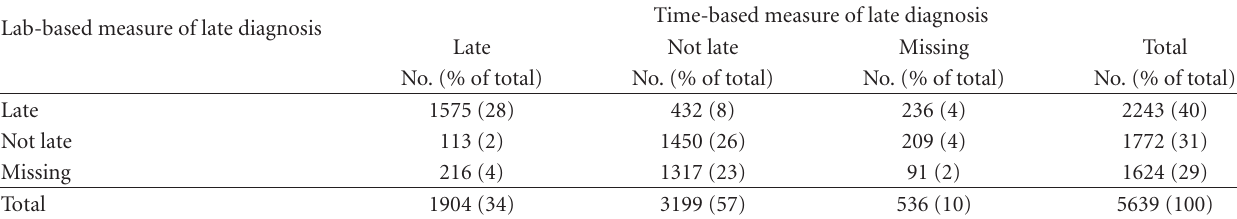
Table 1: Comparing cases meeting two definitions of late HIV diagnosis, 2000–2009.